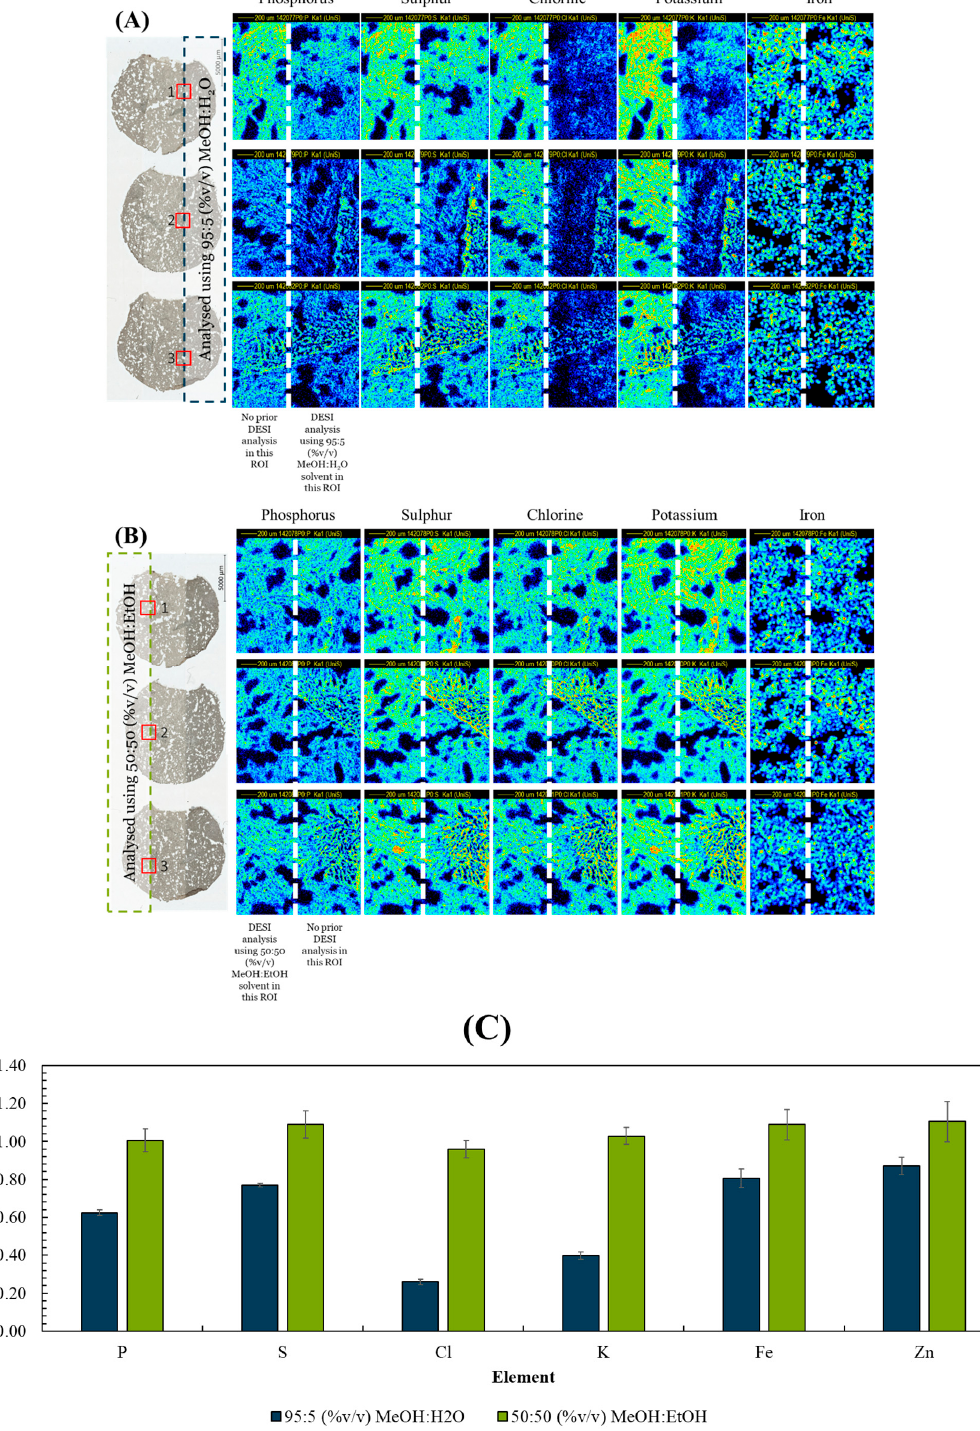
Figure 1. PIXE maps taken post-DESI from 3 sequential liver homogenate sections using an ROI scanned over the edge of the DESI ROI using ( A ) 95:5 (% v/v ) MeOH:H 2 O and ( B ) 50:50 (% v/v ) MeOH:EtOH. The DESI (dotted line) and PIXE ROIs (solid line) are indicated on the far-left image. ( C ) Average ratio ( n = 3) of the elemental peak areas measured by PIXE from ROIs with/without prior DESI. See Figure S1 for further information on the analysis locations for each technique.